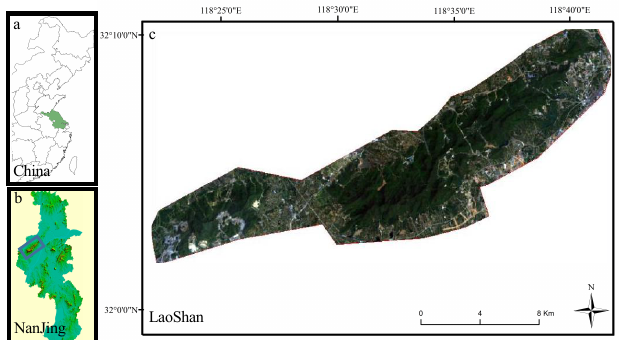
Figure 1. Laoshan National Forest Park is located in Nanjing, Jiangsu Province, China. ( a ) Jiangsu Province, China. ( b ) Laoshan, Nanjing. ( c ) Longitude and Latitude of